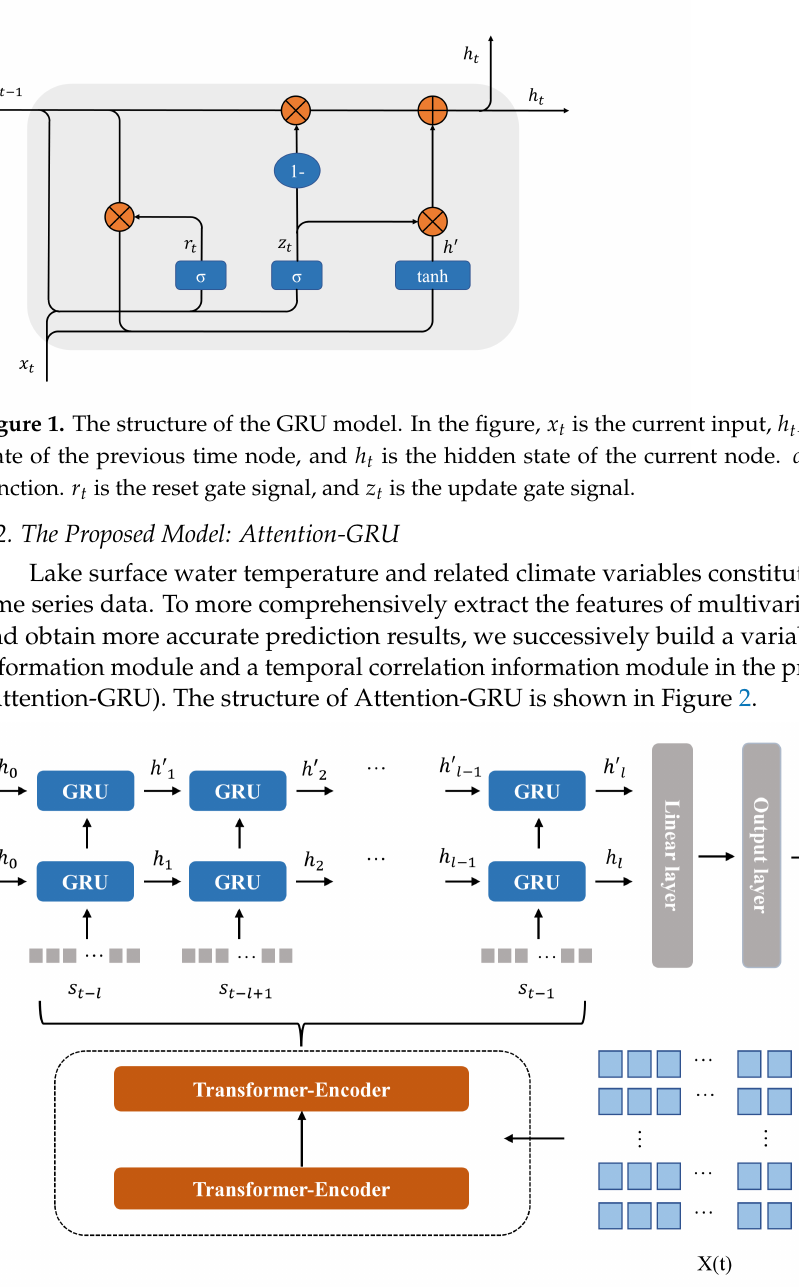
Figure 2. The structure of the Attention-GRU model. X ( t ) is the input data, which is composed of the lake surface water temperature and related climate variables in history. Furthermore, x t − l is the data with a lag of l days, and s t − l is the output after encoding x t − l in the variable correlation information module. Finally, h o is the initial hidden state of the GRU model, h i is the hidden state of the i th time node in the first GRU layer, h (cid:48) is the hidden state of the i th time node in the second GRU layer, and y t i is the prediction result of the